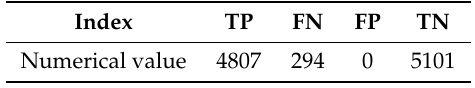
Table 12. Forecast indices value.